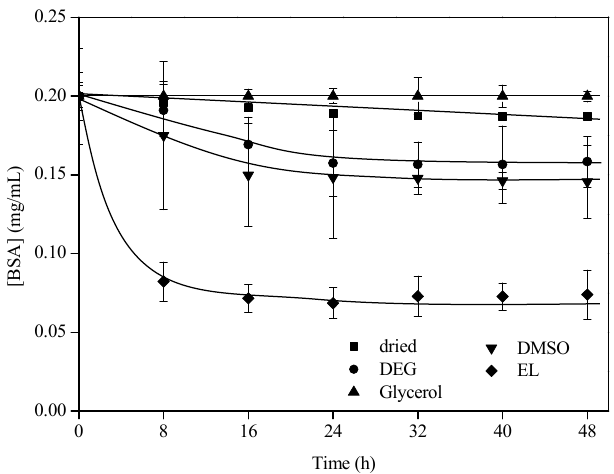
Figure 8. Kinetics of BSA immobilization onto St-MMA-GMA-PEGMA dry and wetted particles with different solvents. All the experiments were carried out with 2.5 g of particles, at 25 °C and with a flow rate of 8 mL/min .